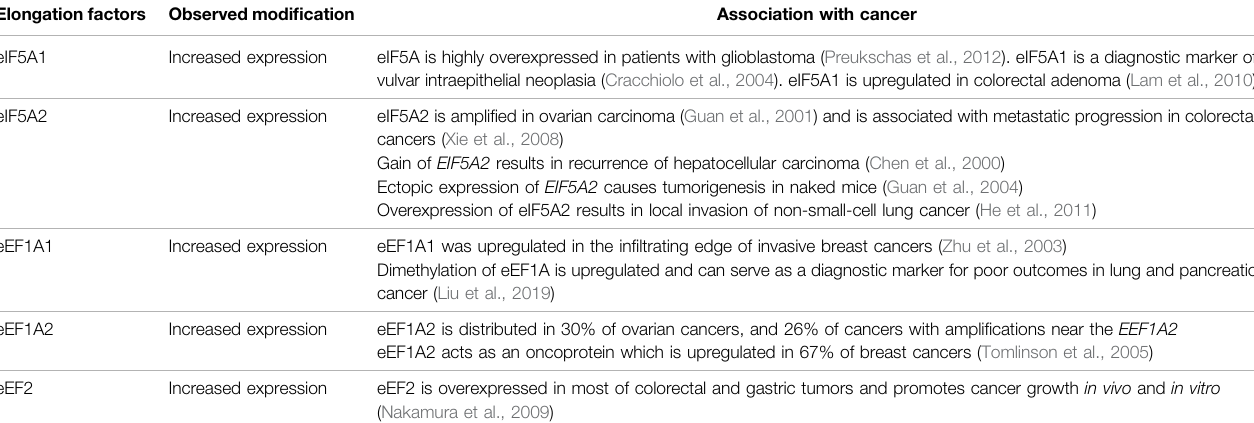
TABLE 2 | Alterations of translation elongation factors in human